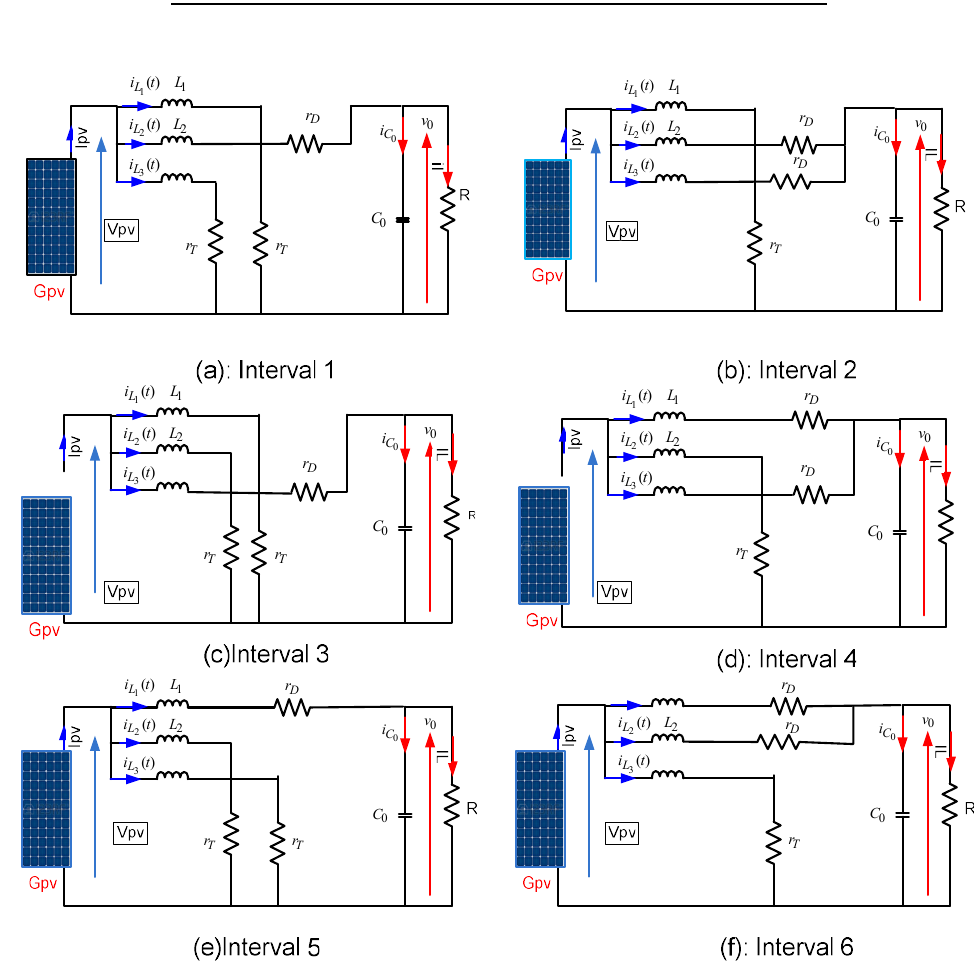
Figure 10. Equivalents schemas of the states of switches over the six intervals.